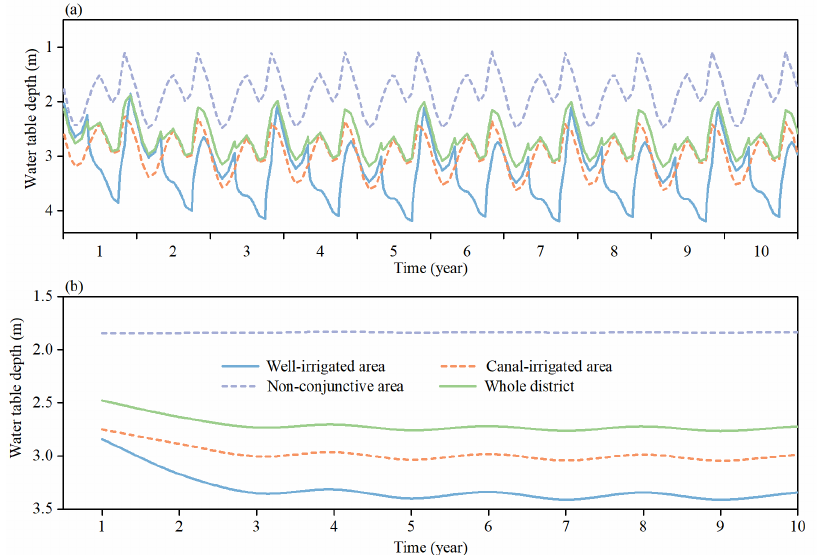
Figure 11. ( a ) Predicted spatial average daily water table depths of different areas in the future 10 years after well-canal conjunctive irrigation, and ( b ) spatial average annual water table depths of different areas in the future 10 years after well-canal conjunctive irrigation. Table 7. Annual average water balance of different areas after well-canal conjunctive irrigation.